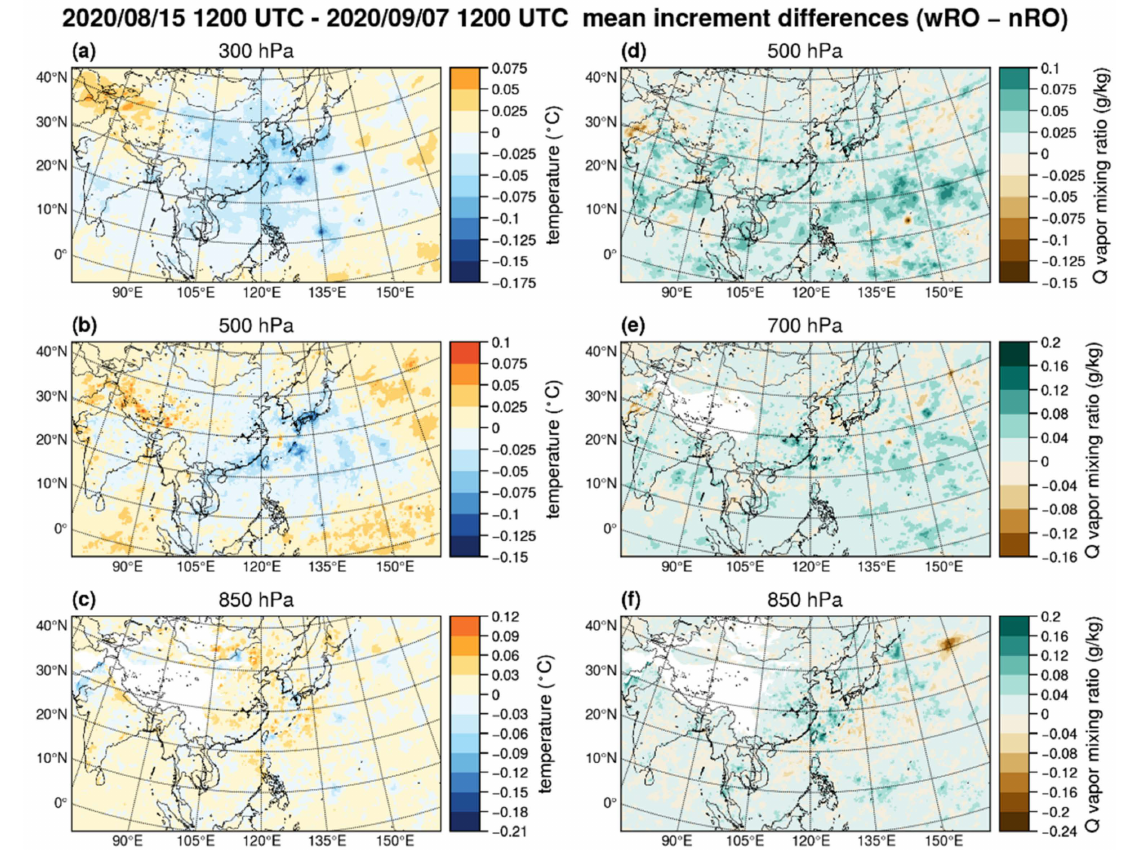
Figure 5. Mean differences of analysis increments between wRO and nRO experiments. The statistic period is the same as that in Figure 2. The mean temperature analysis increment is shown at the left column: ( a ) 300, ( b ) 500, and ( c ) 850 hPa height. The mean water vapor mixing ratio analysis increment is shown at the right column: ( d ) 500, ( e ) 700, and ( f ) 850 hPa. Positive (negative) value indicates that wRO experiment usually has larger (smaller) mean increment than